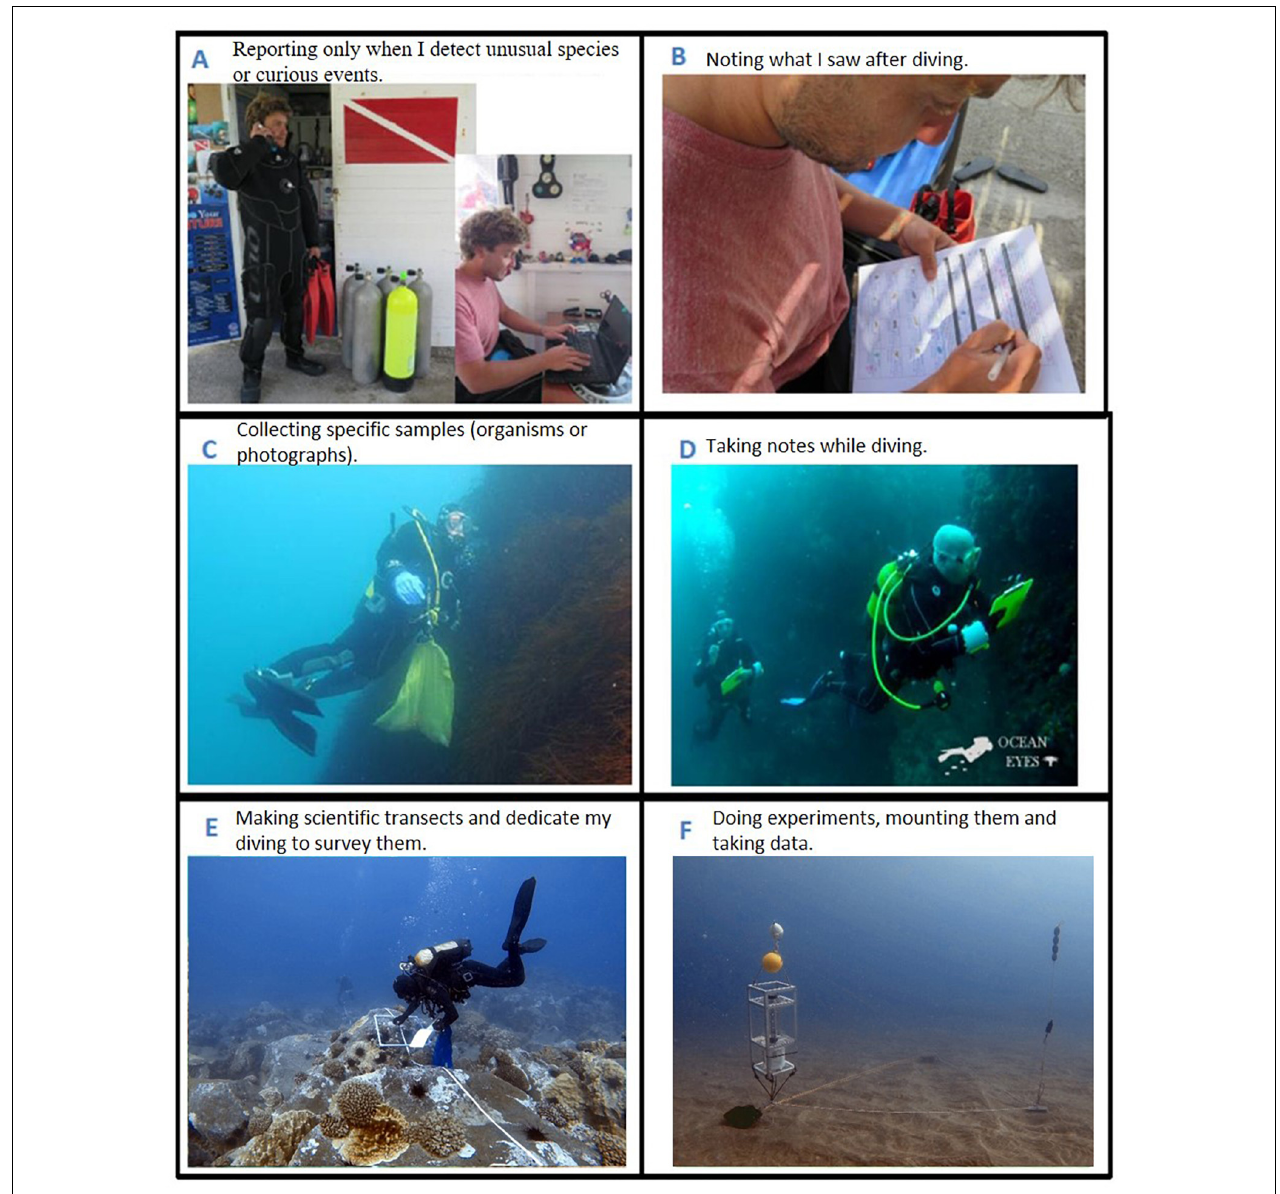
FIGURE 1 | Pictures of the six different protocols presented to divers. A written informed consent was obtained from the individual for the publication of this image. (A) Reporting only when I detect unusual species or curious events. (B) Noting what I saw after diving. (C) Collecting specific samples (organisms or photographs). (D) Taking notes while diving. (E) Making scientific transects and dedicate my diving to survey them. (F) Doing experiments, mounting them, and taking